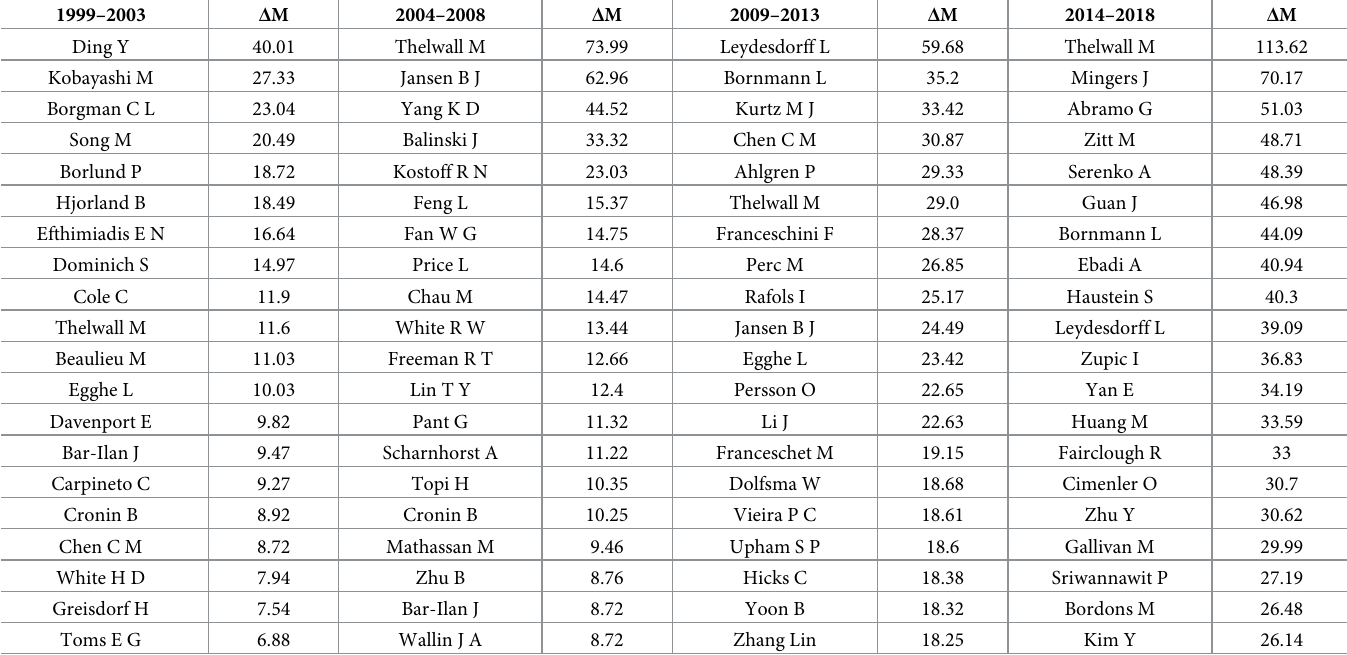
Table 2. Top 20 researchers with the largest Δ M in each of the 5-year time intervals